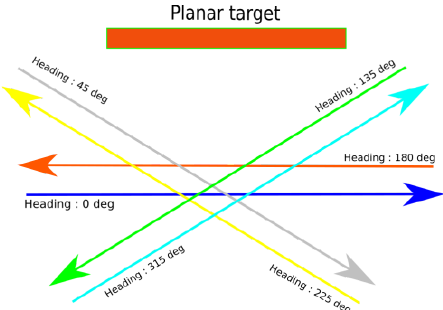
Figure 3 – Simulated trajectory of the six passages w.r.t the planar target